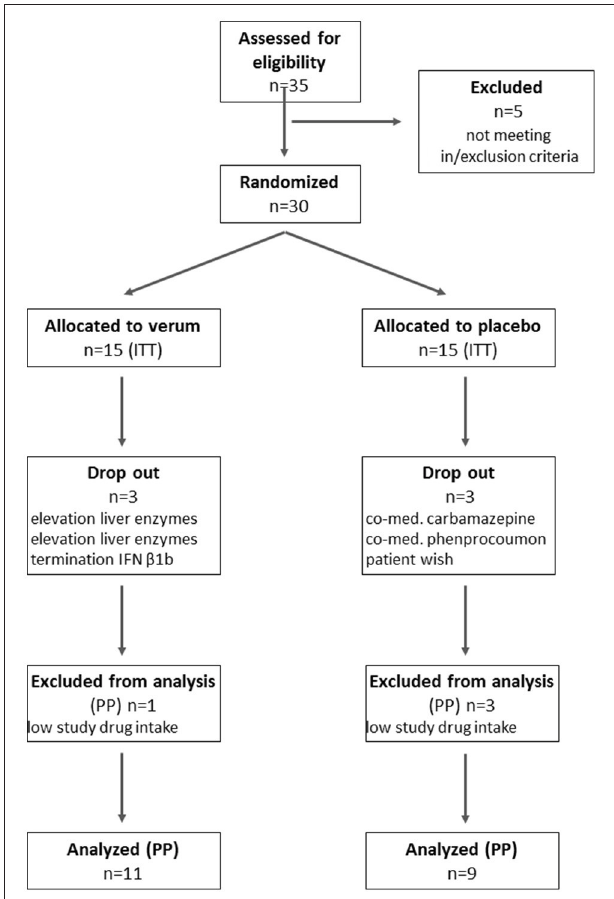
FIGURE 2 | CONSORT flow diagram. ITT, intent to treat; PP, per protocol; n , number.